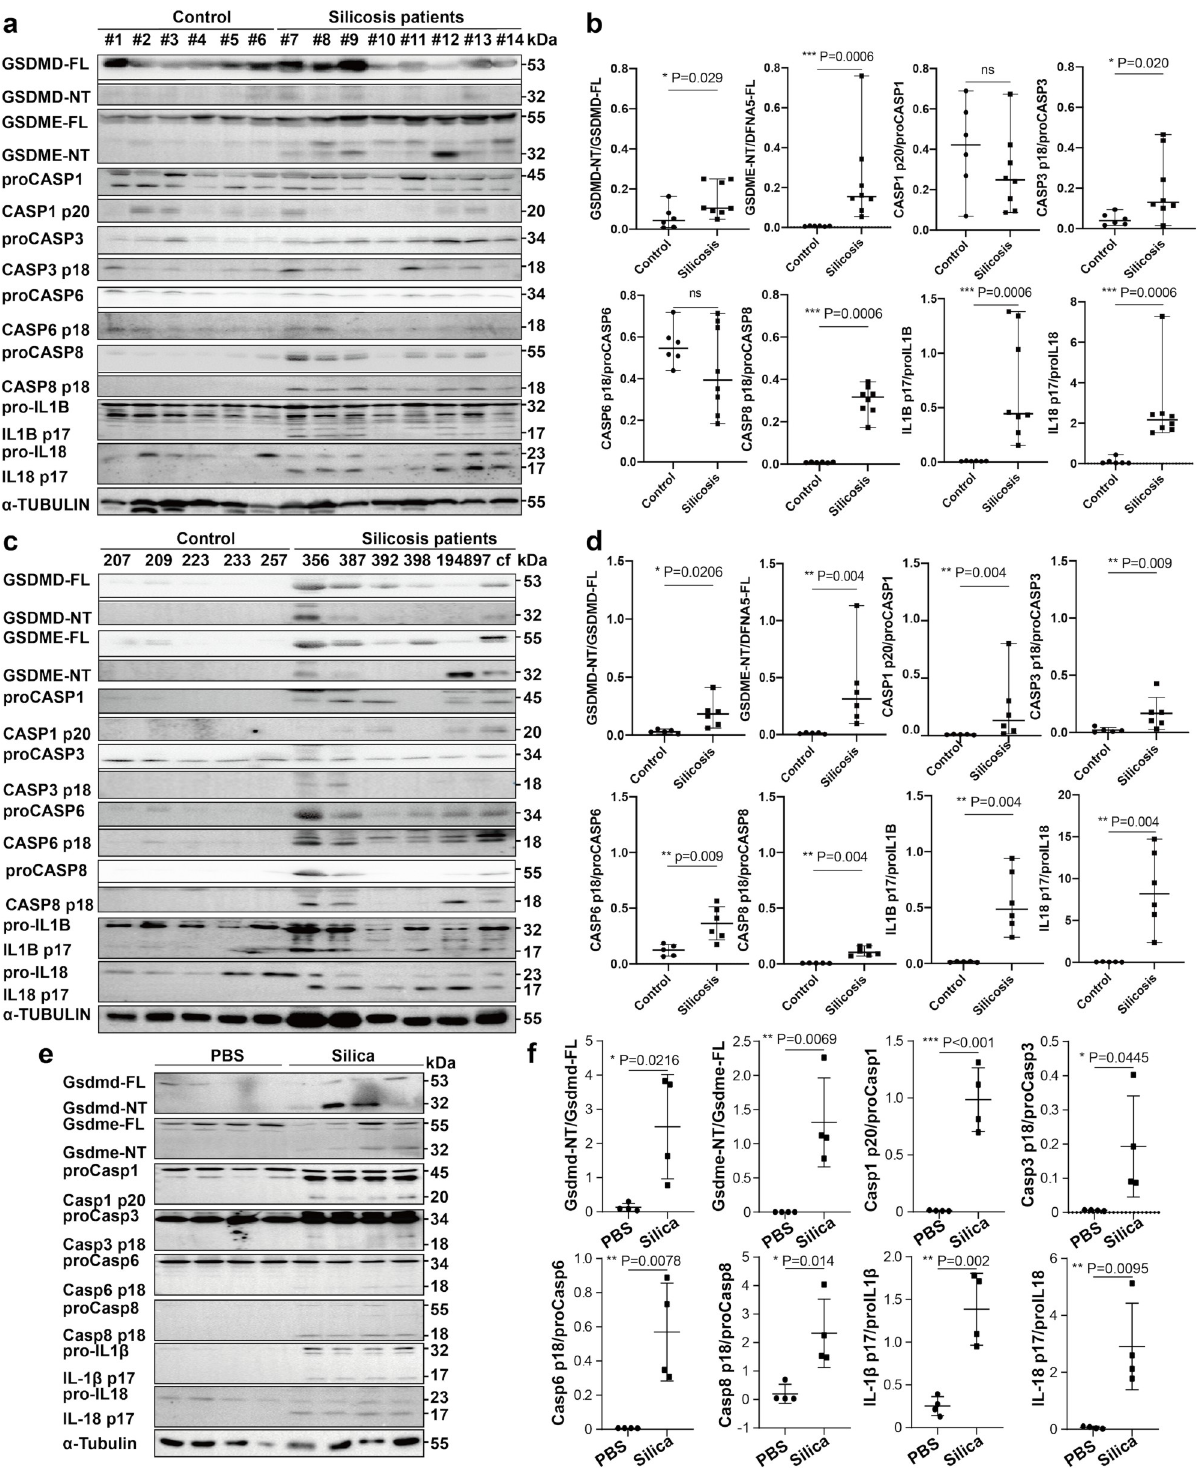
Fig 1. Silicosis is associated with GSDME, GSDMD and caspases cleavage. a GSDMD, GSDME, CASP1, CASP3, CASP6, CASP8, IL1B and IL18 cleavage in controls (#1~#6) and silicosis patients (#7~#14) lung tissues. b Grayscale analysis of ( a ). c Relative protein cleavage in the BALF of controls (207, 209, 223, 233 and 257) and silicosis patients (356, 387, 392, 398, 194897 and cf). d Grayscale analysis of ( c ). e Gsdmd, Gsdme, Caspase-1, Caspase- 3, Caspase-6, Caspase-8, IL-1 β and IL-18 cleavage in mouse BALF, n = 4. f Grayscale analysis of ( e ). Human data were presented as the median ± 95% CI, and analyzed with Mann-Whitney U test. e was expressed as mean ± SD. NS, not significant; � P < 0.05; �� P < 0.01; ��� P < 0.001.